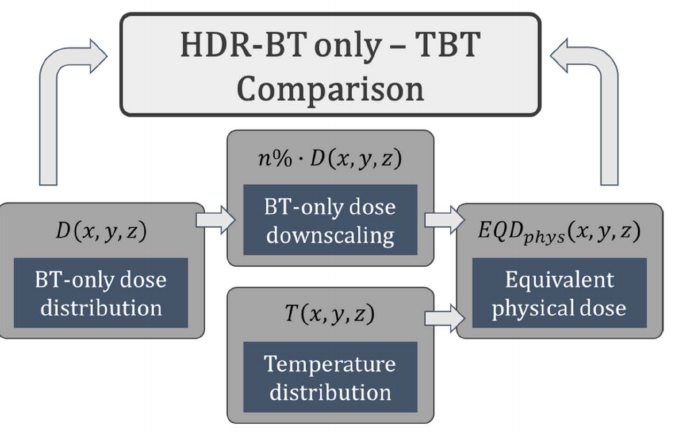
Figure 3. Flowchart illustrating how the TBT EQD phys distribution is generated from and compared with the original BT-only dose